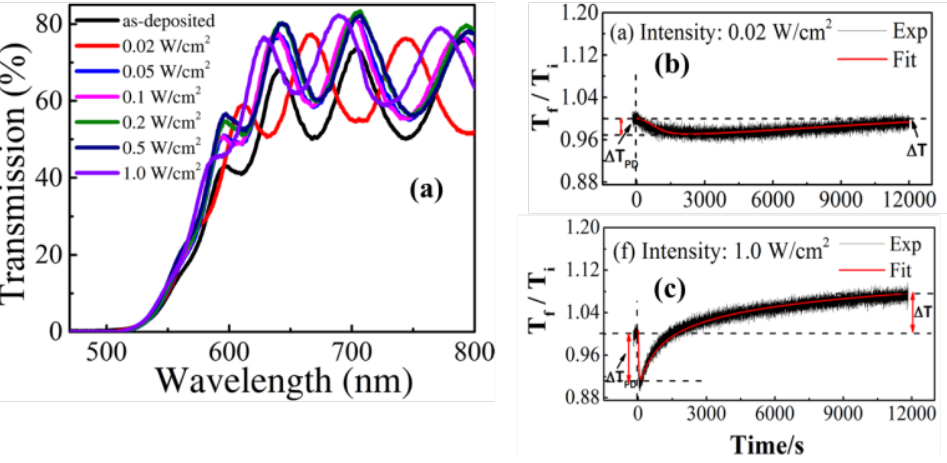
Figure 5. ( a ) Transmission spectra of Ge 16.8 Se 83.2 thin film in as-prepared and illuminated states various power densities of 0.02, 0.05, 0.1, 0.2, 0.5, and 1 W/cm 𝑇 / 𝑇 when excited with low ( b ) 0.02 and high ( c ) 1 W/cm f i are reprinted with permission from [33] Copyright 2017, Springer Nature.